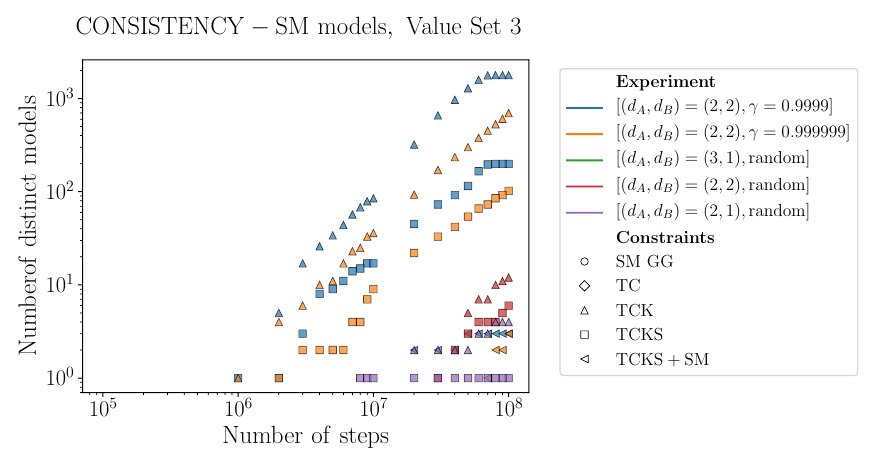
Figure 7 . Experimental results for reward function CONSISTENCY-SM. Results depend on choices of value sets as in table 3. Results for value sets 1, 2, and 3 are at top, middle, and bottom, respectively.